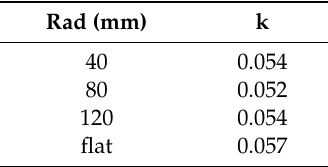
Table 4. Coils coupling coe ffi cient (k) under bending